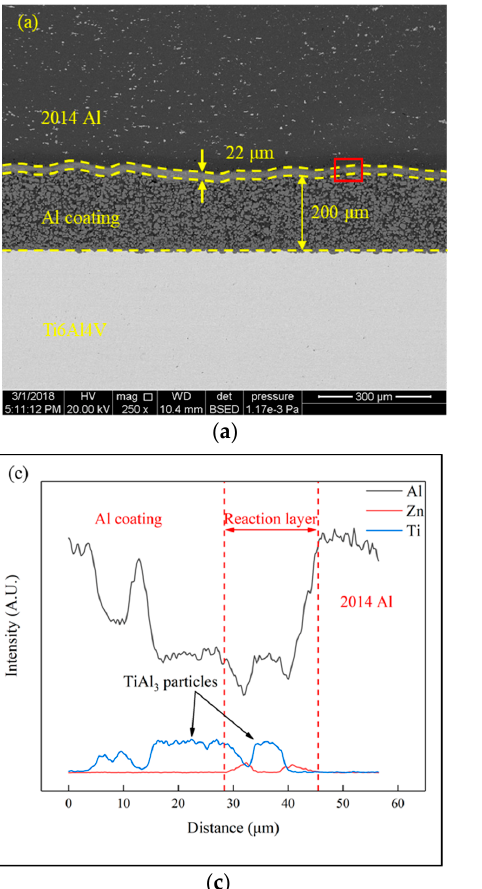
Figure 5. Energy dispersive spectrometry (EDS) element distribution maps of selected regions in the stir zone (red square marked in Figure 4a).